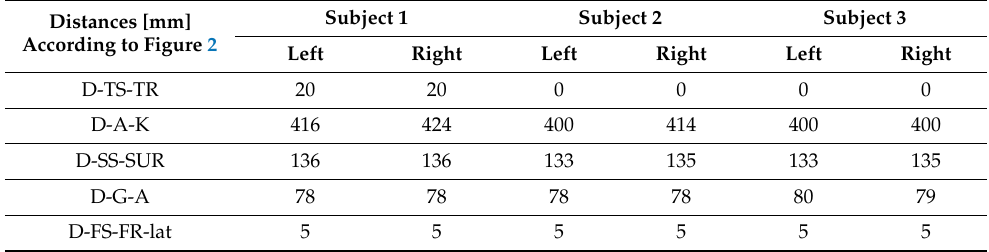
Table 2. Adjusted lengths of the exoskeleton to consider the anthropometry of each